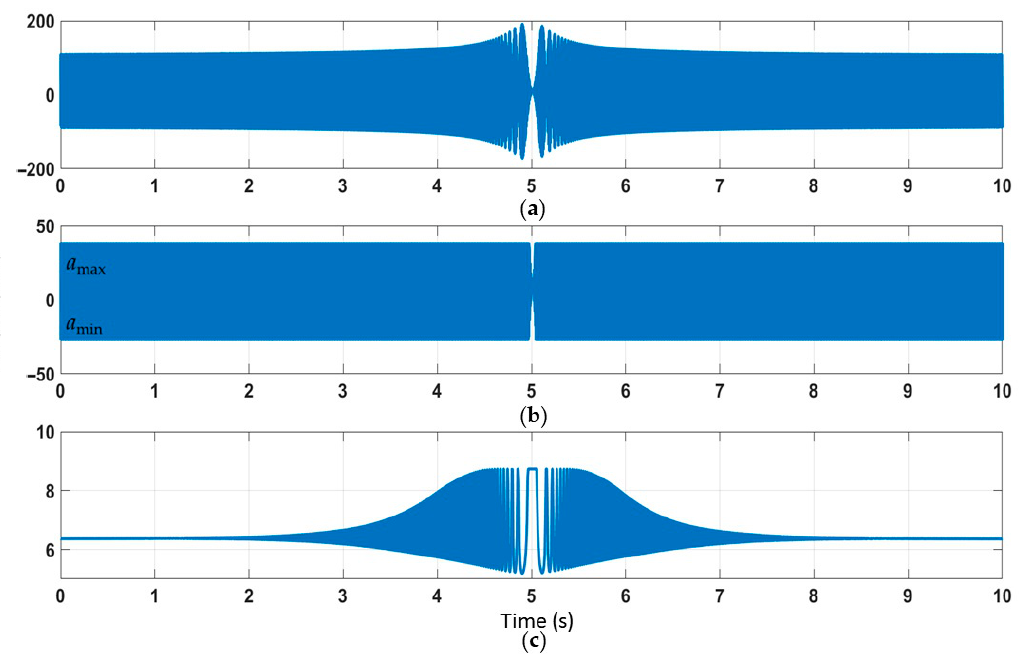
Figure 7. ( a ) The time-domain response of linear frequency sweeping. ( b ) Bilateral asymmetric clipping and low-pass filtering. ( c ) Comparison of experimental data and mathematical model results under the sweeping frequency acoustic attack.